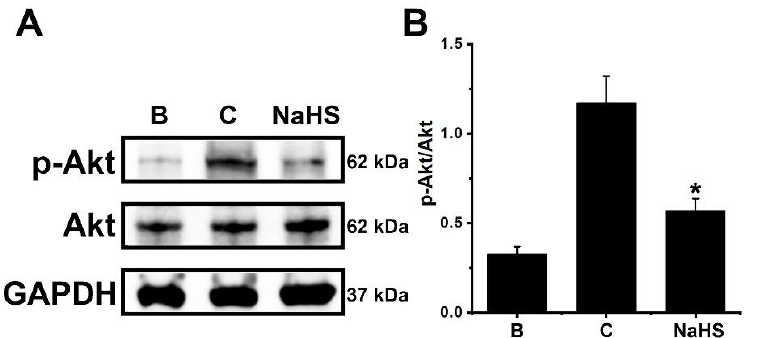
Figure 4. Inhibition of Akt phosphorylation by NaHS in dHL-60 cells. ( A ) Cells (5 × 10 6 /mL) were pretreated with NaHS (1 mM) for 1 h, followed by GM-CSF-stimulation (5 ng/mL) for 30 min. ( B ) The protein levels were quantitated by densitometry. Blank (B) corresponds to PBS treated cells without GM-CSF stimulation, and control (C) corresponds to PBS treated cells stimulated by GM-CSF. Results are expressed as the mean ± SEM from three separate experiments. * p < 0.05, as compared with the PBS treated cells stimulated by GM-CSF.